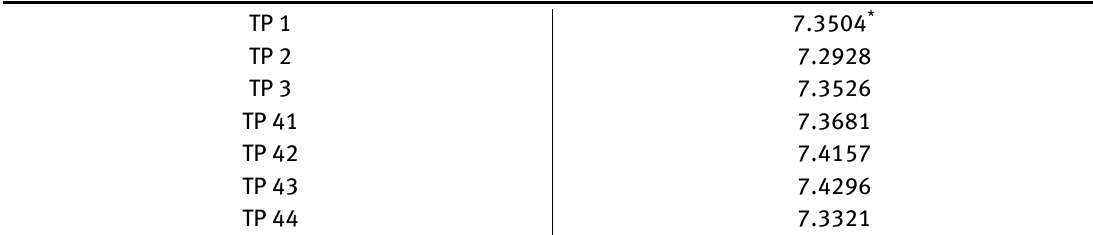
Table 3: Average number of accurate